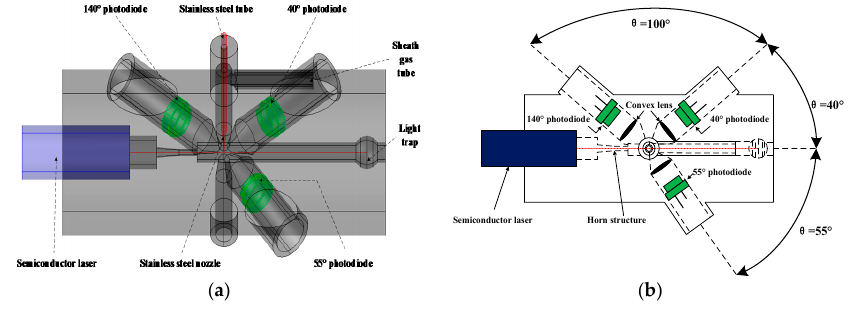
Figure 1. Diagram of the particle sensor: ( a ) 3D view; ( b ) Top-down view.